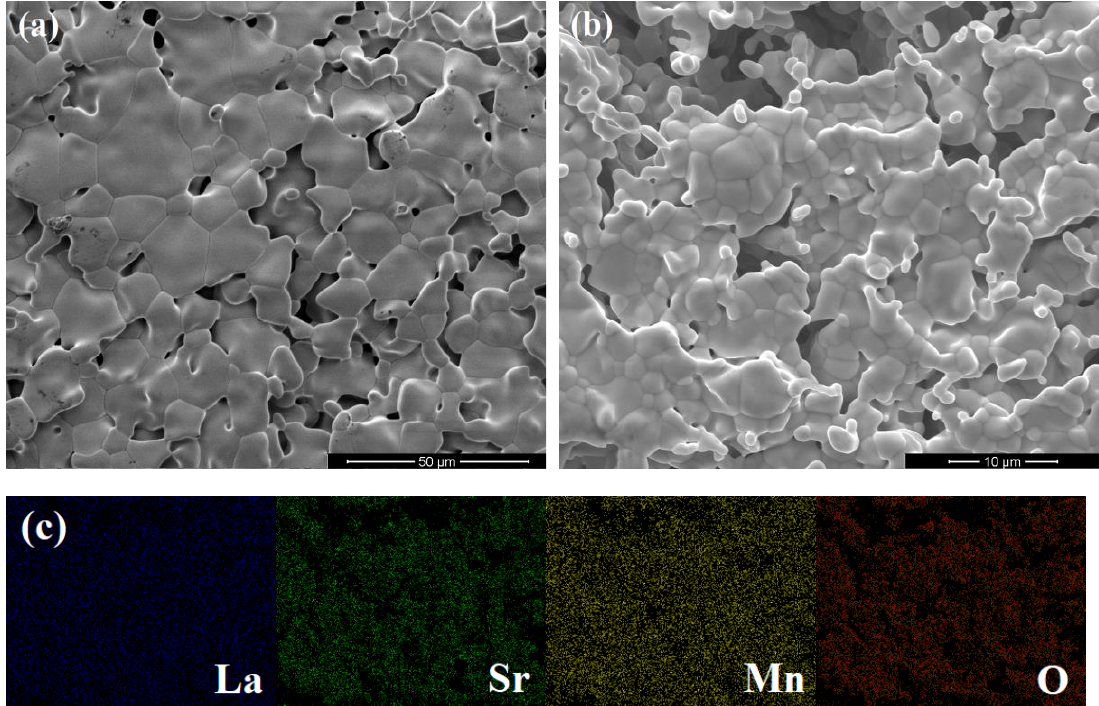
Figure 3. Scanning electron microscopy (SEM) images of: ( a ) The porous ceria pellet, ( b ) The porous LSM40 pellet before cycling and ( c ) the corresponding energy dispersive X-ray spectroscopy (EDX) maps of the porous LSM40 pellet.